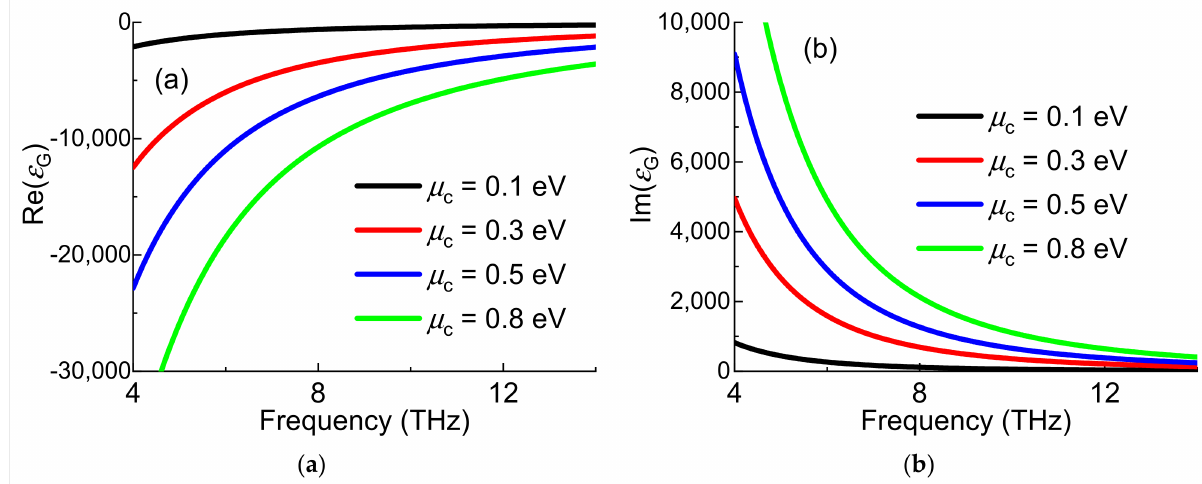
Figure 2. The ( a ) real part and ( b ) imaginary part of effective permittivity of graphene varied with frequency. The proposed metamaterial structure was calculated by applying the finite integral time domain (FITD) method. The boundary condition ofx and y directionsare unit cell and the z -axis is open. The proposed structureconsists of graphene strip and LC layer patches on the opposite sides of polyimide layer of substrate in Figure 3. The structure parameters are as follows: l = 18 µ m, h = 15 µ m, t 1 = 1.6 µ m, t 2 = 0.3 µ m, d G = 1 nm, w = 0.3 µ m,